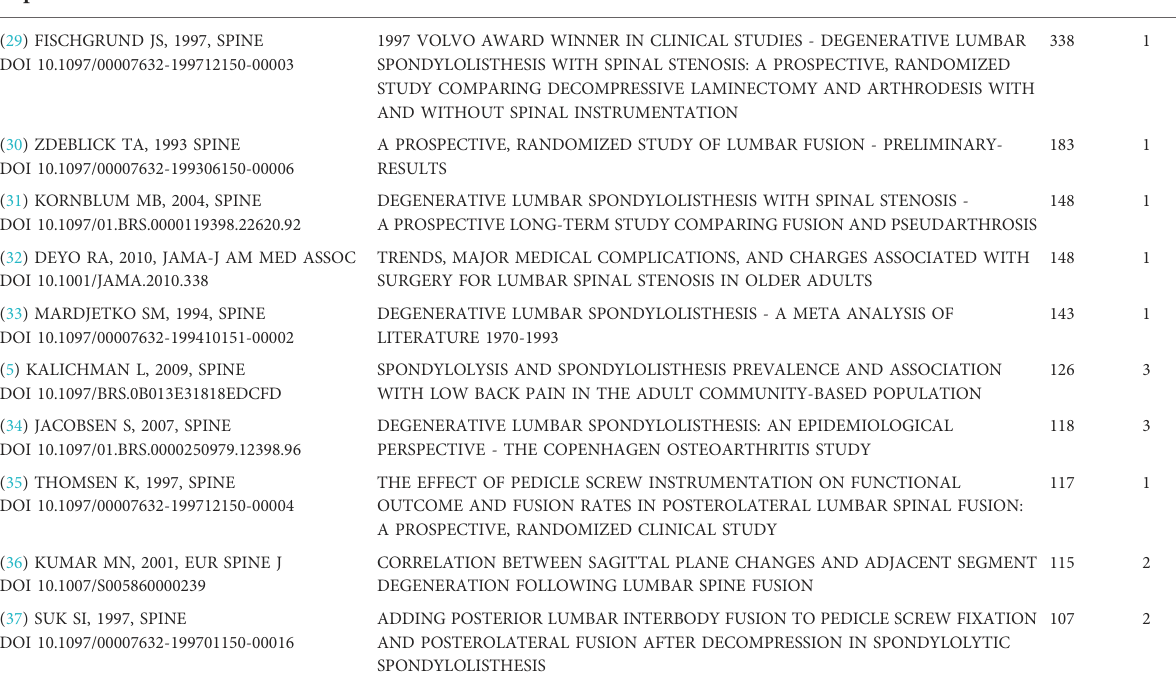
TABLE 4 Top-10 cited articles concerning lumbar spondylolisthesis.